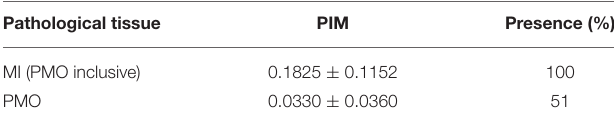
TABLE 2 | The proportion of scar tissues among pathological